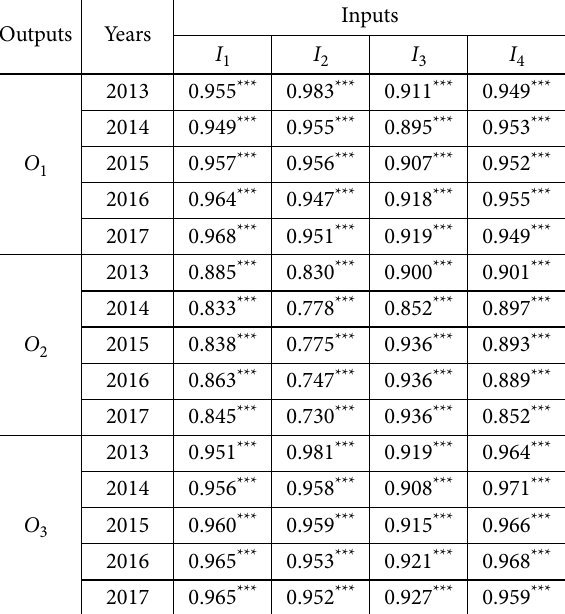
Table 3. Pearson correlation coefficients between inputs